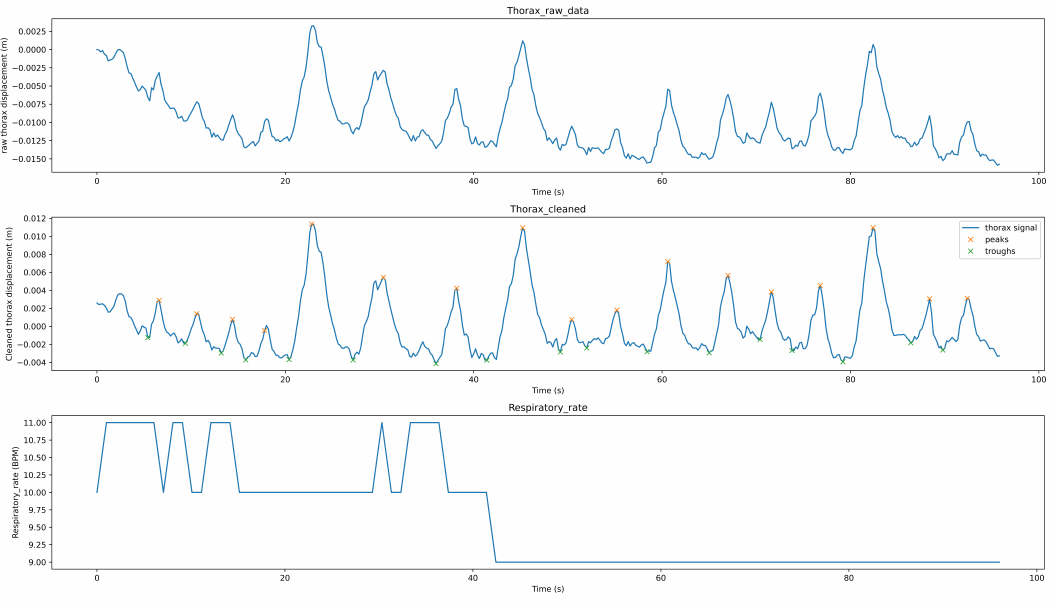
Figure 9. Breathing analysis for a beginner